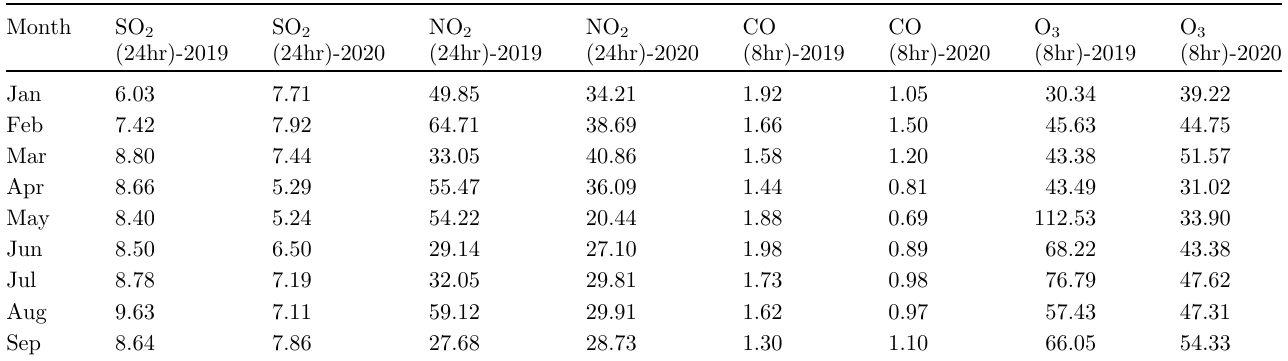
Table 4. Colours and classes for AQI (cid:1) UAE.